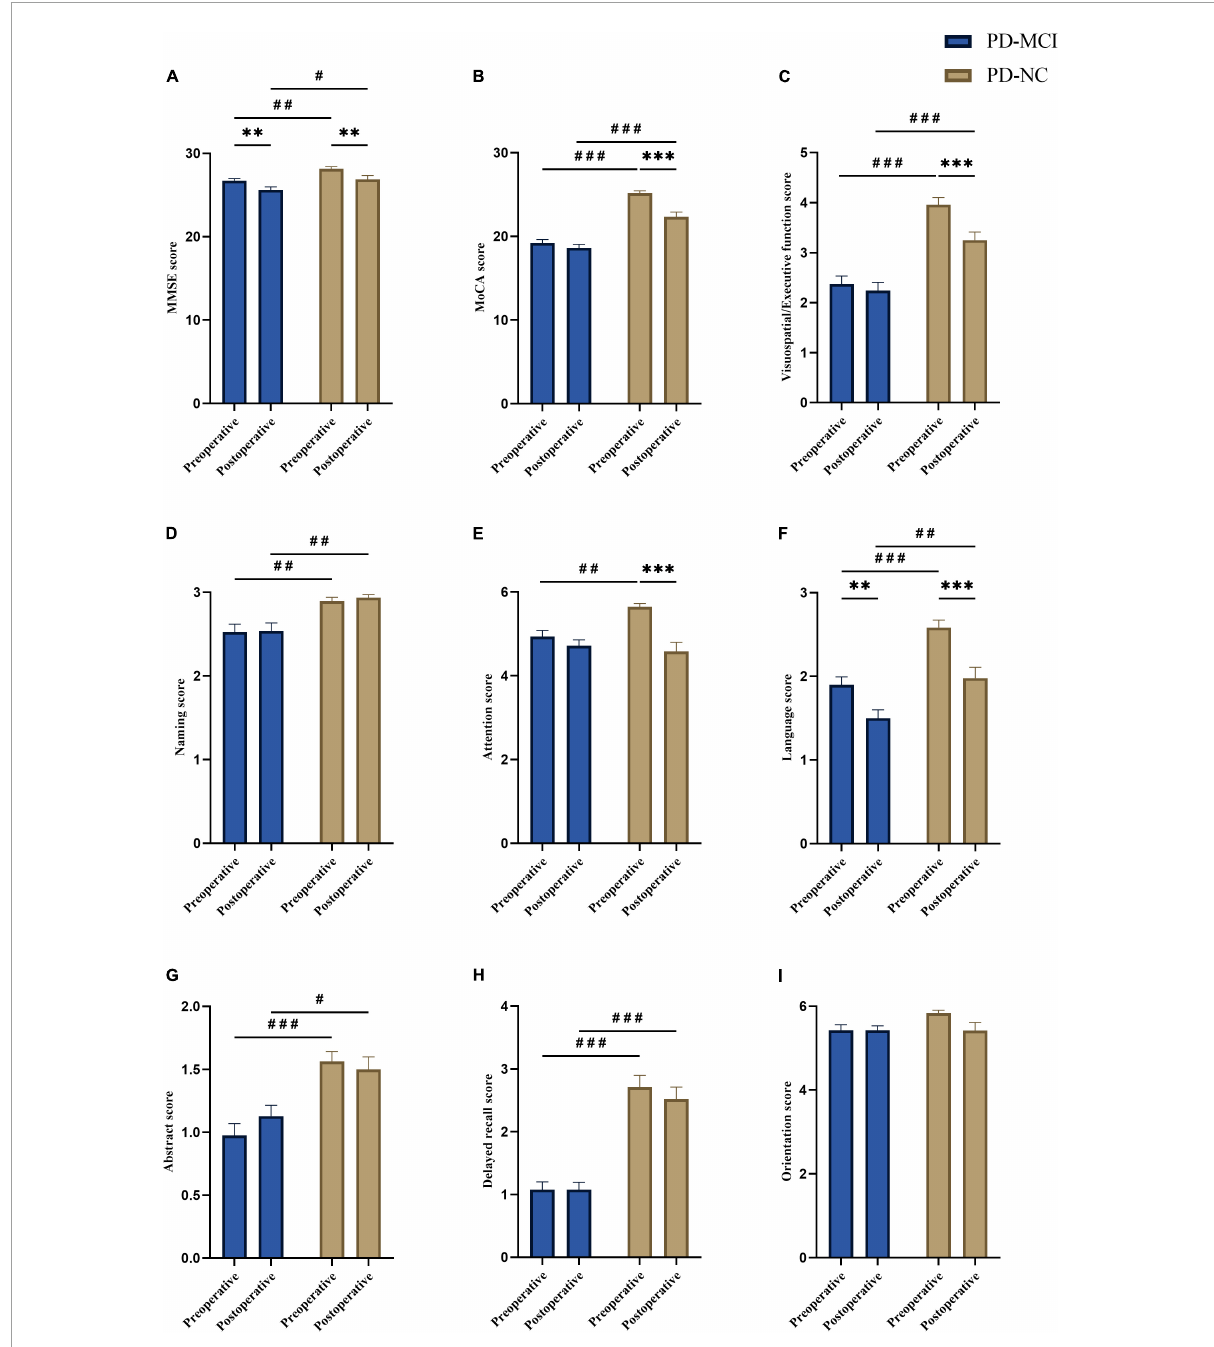
FIGURE2 Comparison of pre- and post-operative cognitive scores between groups. Compare to pre-operative, (A) overall MMSE scores (PD-MCI: ∗∗ p = 0.002; PD-NC: ∗∗ p = 0.006) and language scores (PD-MCI: ∗∗ p = 0.001; PD-NC: ∗∗∗ p < 0.001) showed decline in PD-MCI and PD-NC groups. (B) Overall MoCA scores ( ∗∗∗ p < 0.001), (C) visuospatial/executive function ( ∗∗∗ p < 0.001) and (E) attention ( ∗∗∗ p < 0.001) showed significant post-operative decline in PD-NC group. Compare to PD-NC group, PD-MCI group showed lower score in (A) overall MMSE (pre-operative: ## p = 0.009; post-operative: # p = 0.02), (B) overall MoCA (pre-operative: ### p < 0.001; post-operative: ### p < 0.001), (C) visuospatial/executive function (pre-operative: ### p < 0.001; post-operative: ### p < 0.001), (D) naming (pre-operative: ## p = 0.007; post-operative: ## p = 0.003), (F) language (pre-operative: ### p < 0.001; post-operative: ## p = 0.004), (G) abstract (pre-operative: ### p < 0.001; post-operative: # p = 0.013), and (H) delayed recall (pre-operative: ### p < 0.001; post-operative: ### p < 0.001) in both pre- and post-operative, and (E) attention ( ## p = 0.003) in pre-operative. No significant difference was found in orientation (between pre- and postoperative within-group, or between-groups) (I) . The data were analyzed by two-way repeated-measures ANOVA with group (PD-MCI and PD-NC) as the between group factor and time (before and after DBS) as the within group factor, followed by Bonferroni’s post-hoc tests. All graphs are depicted with bars for standard errors of the mean (SEM) and p -values (two-tailed) with the following significance level: ∗∗ p < 0.01; ∗∗∗ p < 0.001 (within-group comparison); # p < 0.05; ## p < 0.01; ### p < 0.001 (between-group comparison). PD-MCI, Parkinson’s disease with mild cognitive impairment; PD-NC, Parkinson’s disease with normal cognition; MoCA, Montreal Cognitive Assessment; MMSE, Mini-Mental State